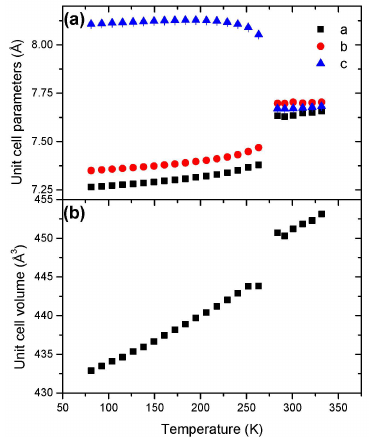
Figure 6. Temperature dependence of ( a ) the unit cell parameters and ( b ) the unit cell volume for HBB in the temperature range 81–332 K.